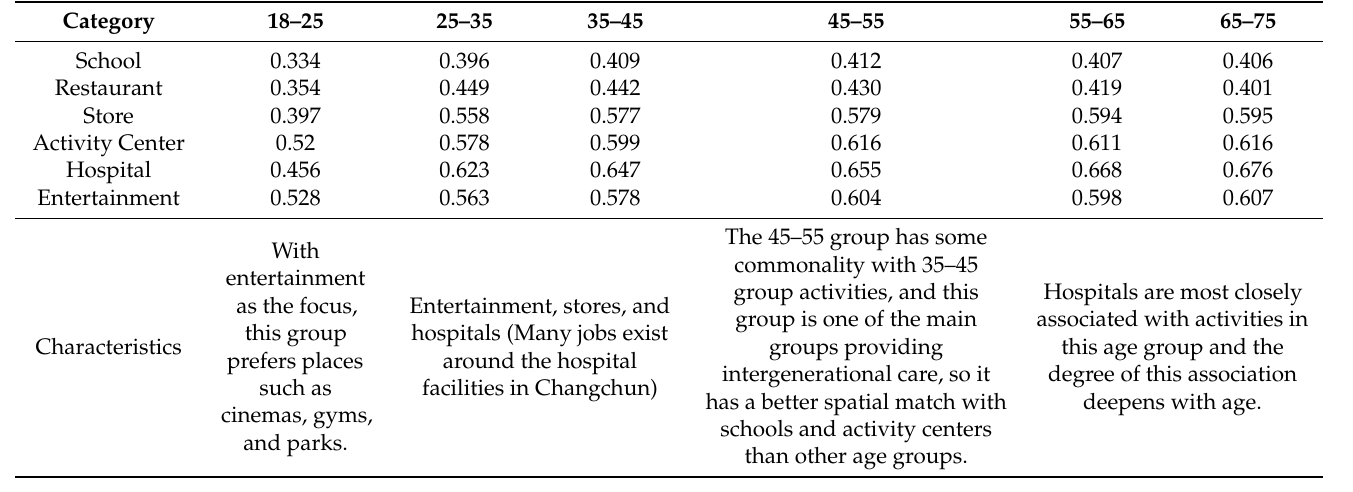
Table 3. Spatial matching by age